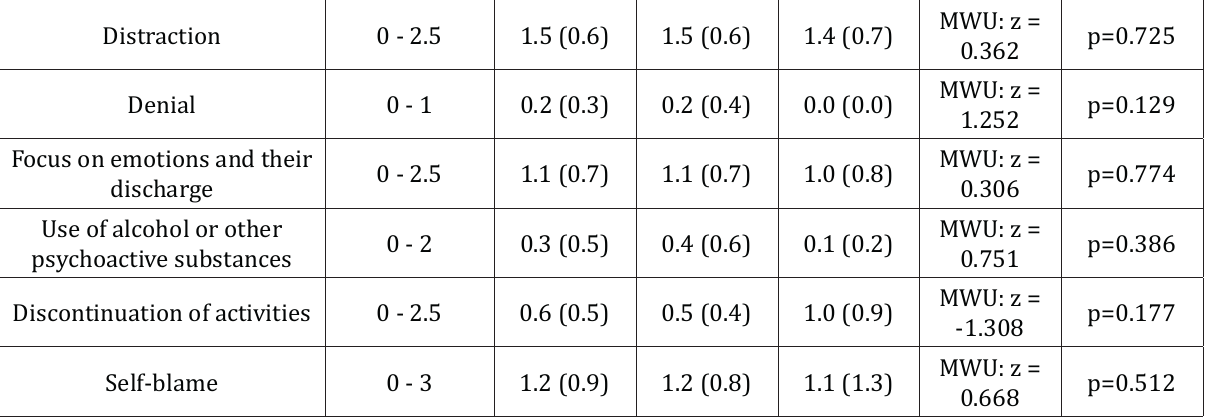
Table 2. Characteristics broken down by